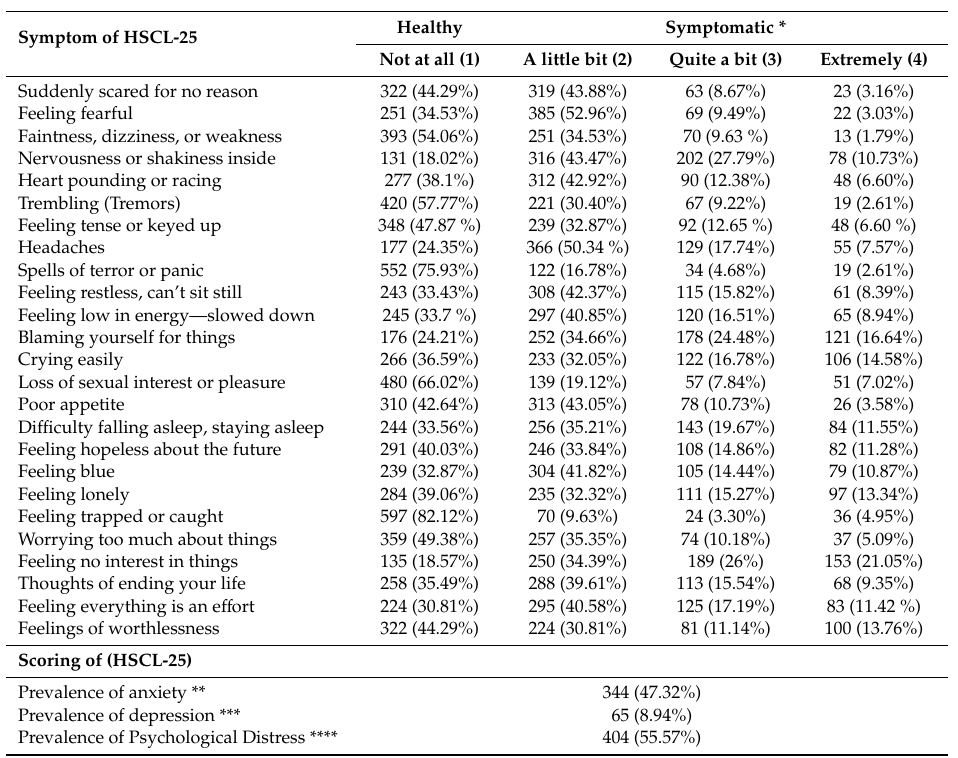
Scoring of (HSCL-25) Prevalence of anxiety ** 344 (47.32%) Prevalence of depression ***